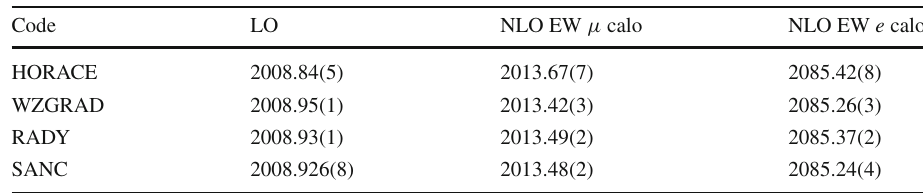
total cross sections (in pb) for pp → γ, Z → l − l + + X at the 8 TeV LHC, with ATLAS/CMS cuts and bare leptons. ( × ) indicates that FEWZ provides NLO EW results only in the G μ scheme, and thus no results are available for the setup of the tuned comparison (see Sect. 2.1)